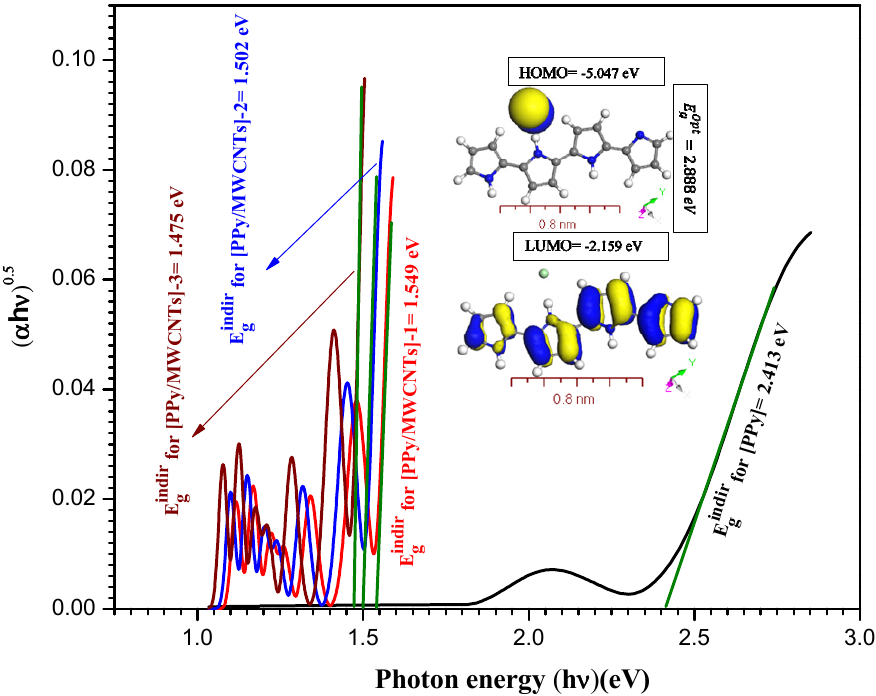
Figure 5. Plot indirect transitions ( α h ν ) 0.5 vs. photon energy ( h ν ) eV for [PPy], Inset figure the theoretical calculation highest occupied molecular orbital (HOMO) and lowest unoccupied molecular orbital (LUMO) for PPy gas phase.